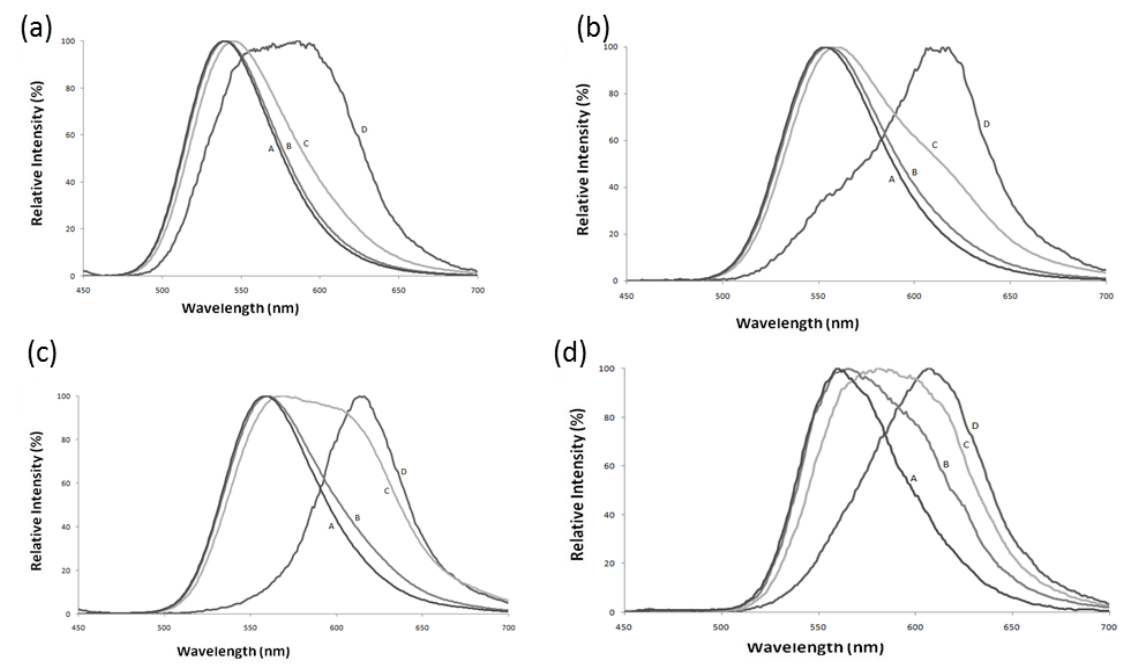
Figure 2. Effect of pH on bioluminescence spectra of four firefly luciferases displaying distinct pH sensitivities. Reprinted with permission from ref. [29]. Copyright 2011 Royal Society of Chemistry. ( a ) Amydetes viviani ; ( b ) Cratomorphus distinctus ; ( c ) Photinus pyralis, and ( d ) Macrolampis sp2. (A) pH 6.5; (B) pH 7.0; (C) pH 7.5, and (D) pH 8.0.